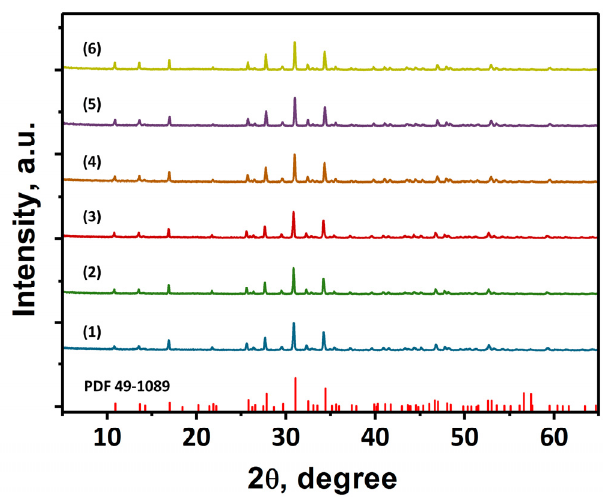
Figure 1. PXRD patterns for Ca 9 Gd 0.9 − x Tm 0.1 Sm x (PO 4 ) 7 ( x = 0 (1); 0.2 (2); 0.3 (3))